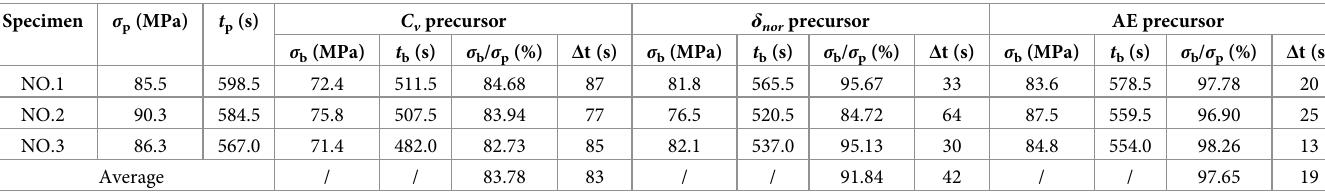
Table 1. The precursor stress and time for the three